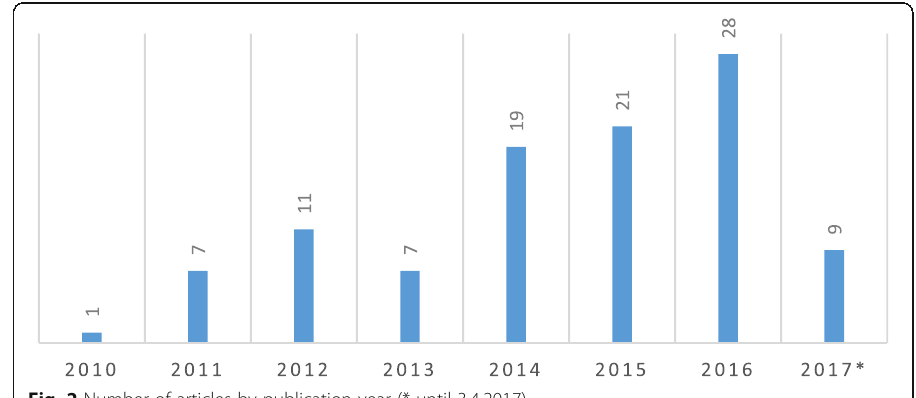
Fig. 2 Number of articles by publication year (* until